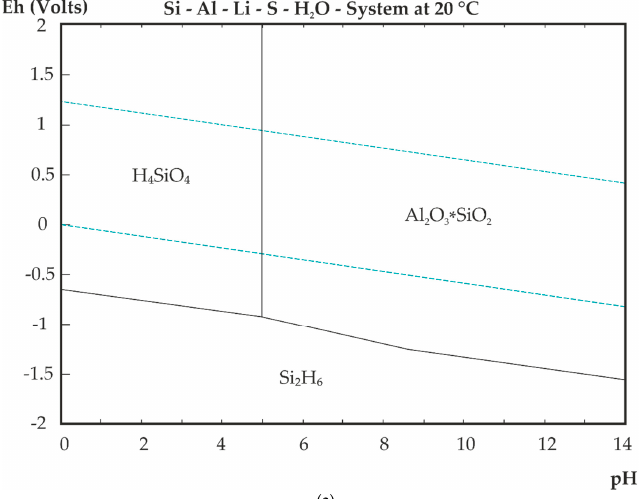
Figure 5. Eh-pH diagram for Al-Li-S-Si-H 2 O system: ( a ) 20 °C; ( b ) 80 °C. Molarity: (Li) = 1 M, (Al) = 0.5 M, (S) = 0.5 M and (Si) = 0.05 M.